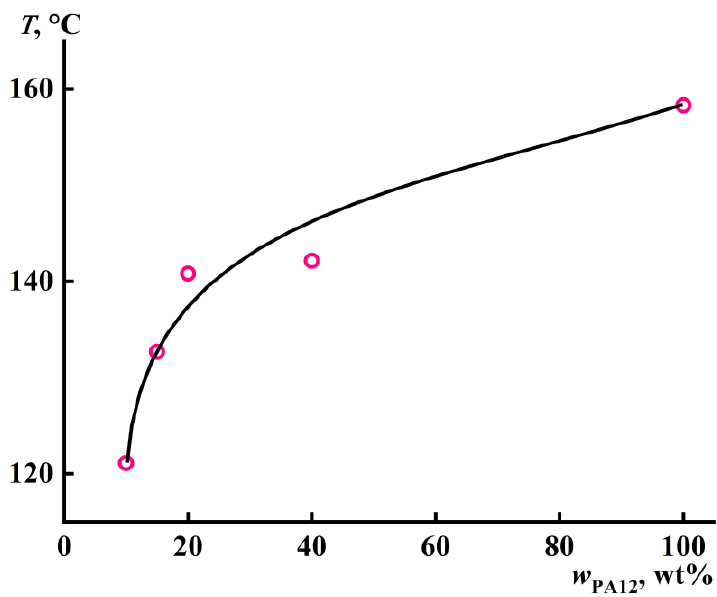
Figure 6. Concentration dependence of the crystallization temperature of the polylaurolactam solution in benzyl alcohol.